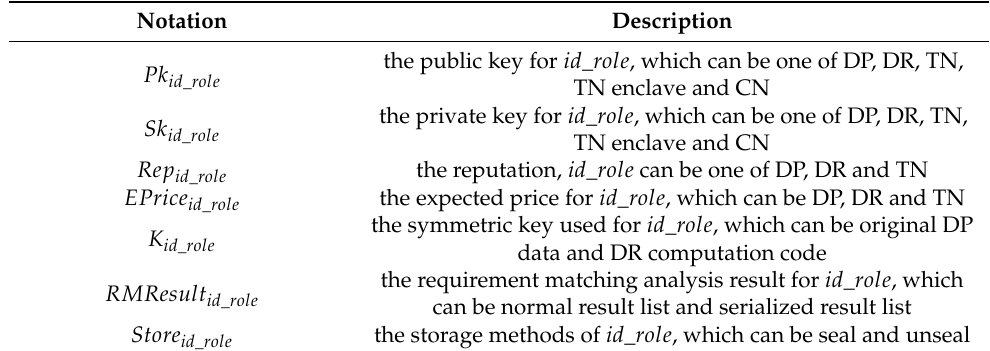
Table 2. Role notation